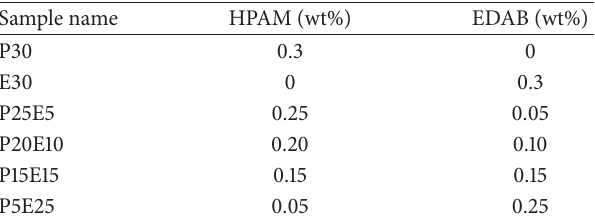
Scheme 1: Molecular structures of HPAM and EDAB used in this work. Table 1: The nomenclature and compositions of chemicals used in this